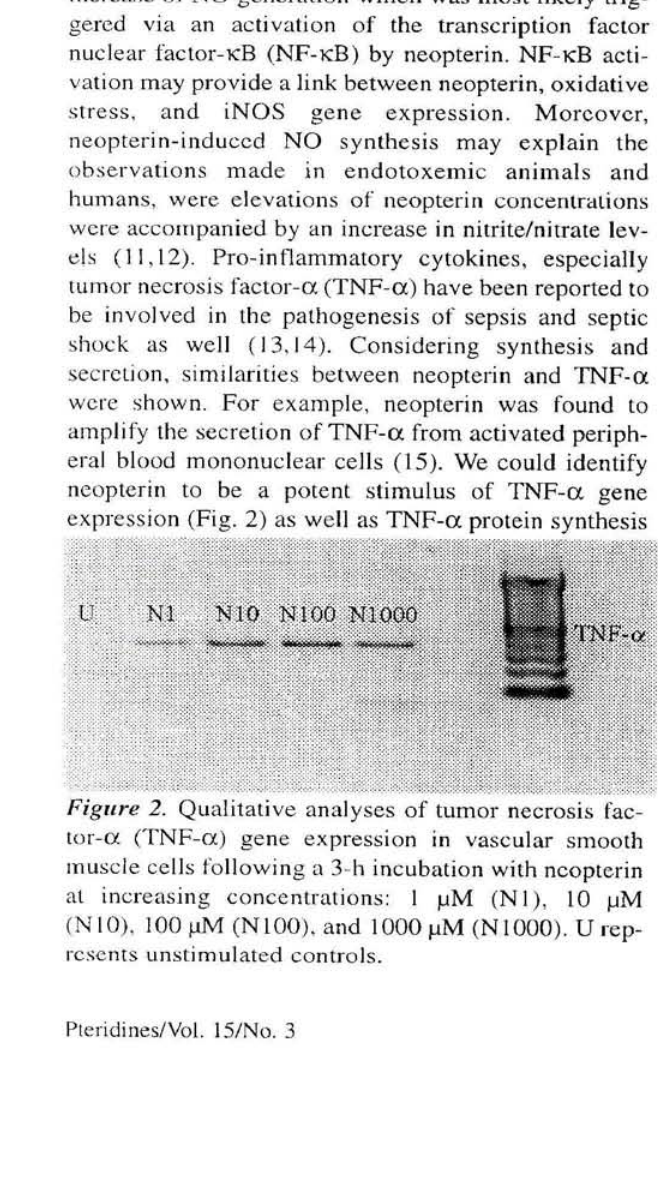
Pteridines/Vol. 15/No.